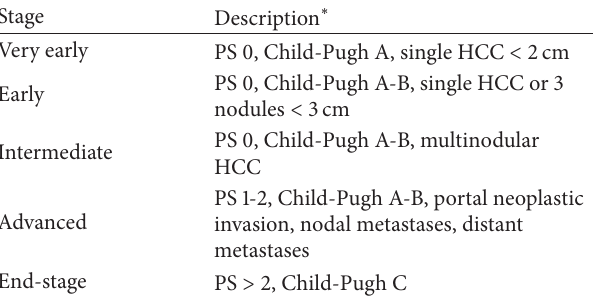
Table 1: BCLC classification in patients diagnosed with